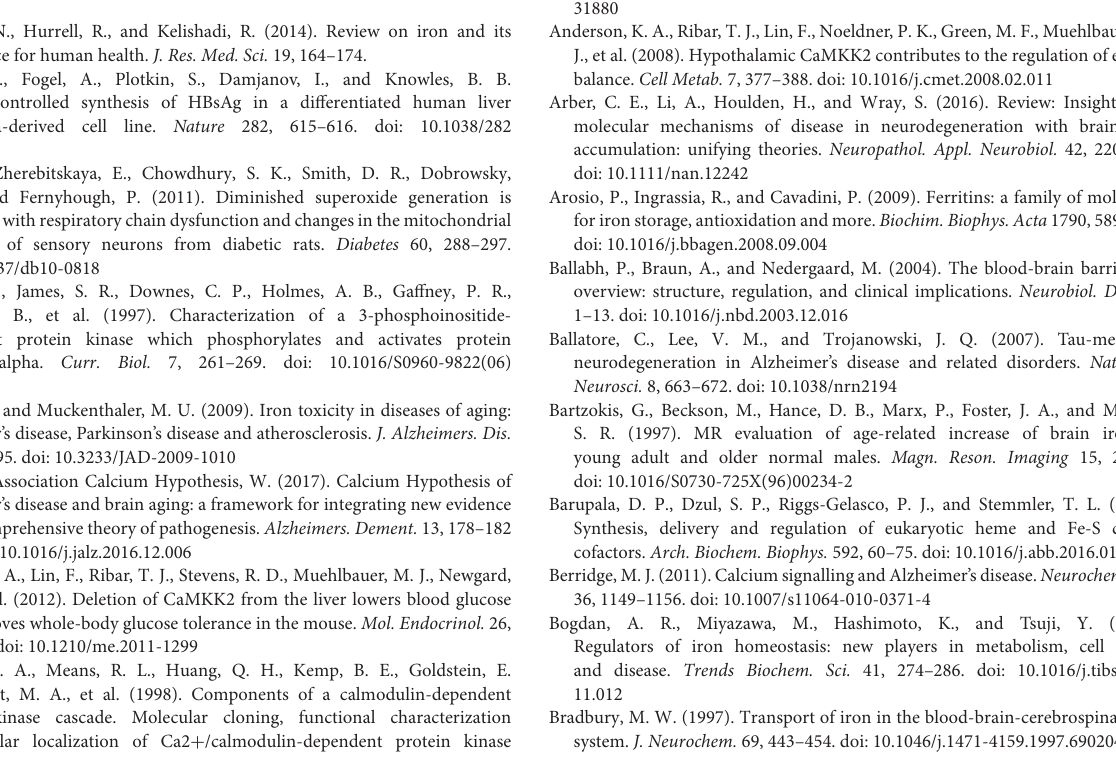
(pink), green highlighted residues in the N-lobe that may interact with the human TFR(Cheng et al., 2004). Each of the homologous N and C terminal domains of TF binds one ion of ferric iron. The amino acid residues involved in TF iron binding are mentioned by light pink highlights (Wally et al., 2006; Noinaj et al., 2012; Wang et al., 2015). (B) Phylogenetic tree of TF. The horizontal lines are branches and represent evolutionary lineages changing over time. The values indicate the length of the branch that represents an amount genetic change equivalent to the length. The units of the branch length are usually nucleotide substitutions per site (the number of changes or “substitutions” divided by the length of the sequence). The phylogenetic tree was constructed using Clustal Omega web tool. Supplementary Figure 2 | Muscarine treatment induced intracellular calcium response in wild-type and CaMKK2 KO HEK293 cells. (A,D) Line graphs showing time-lapse Fluo-4 intensities in wild-type and CaMKK2 KO HEK293 cells. Each thin line indicates data obtained using from a single cell. The thick line represents the mean. N = 12. Detailed methodology is mentioned in the text. (B,C,E,F) Scatter plot showing Fluo-4 intensities in wild-type and CaMKK2 KO HEK293 cells following 3.5 and 10min of 10 µ M muscarine. Data represent Mean ± SEM. The p -value by t -test (unpaired). Supplementary Figure 3 | Relative abundance of total TF in the CSF and serum samples obtained from postmortem human EOAD and LOAD patients and age matched unaffected controls. (A,C,G,H) Immunoblots showing expression of total TF the CSF and serum samples. Bottom panels represent SDS-PAGE gel stained with Oriole to show total protein loading. Black arrow indicates the band used for normalization of TF expression. (B) Scatter plot showing relative abundance of the TF in the CSF based on immunoblots shown in (A) . (D,F) Scatter plot showing relative abundance of the TF in the CSF and matched serum from the same individuals based on the immunoblots shown in (C) . Black arrows in stained gel indicates the band used for normalization of TF expression. (G,H) Immunoblots showing expression of total TF the CSF and serum samples. Bottom panels represent SDS-PAGE gel stained with Oriole to show total protein loading.